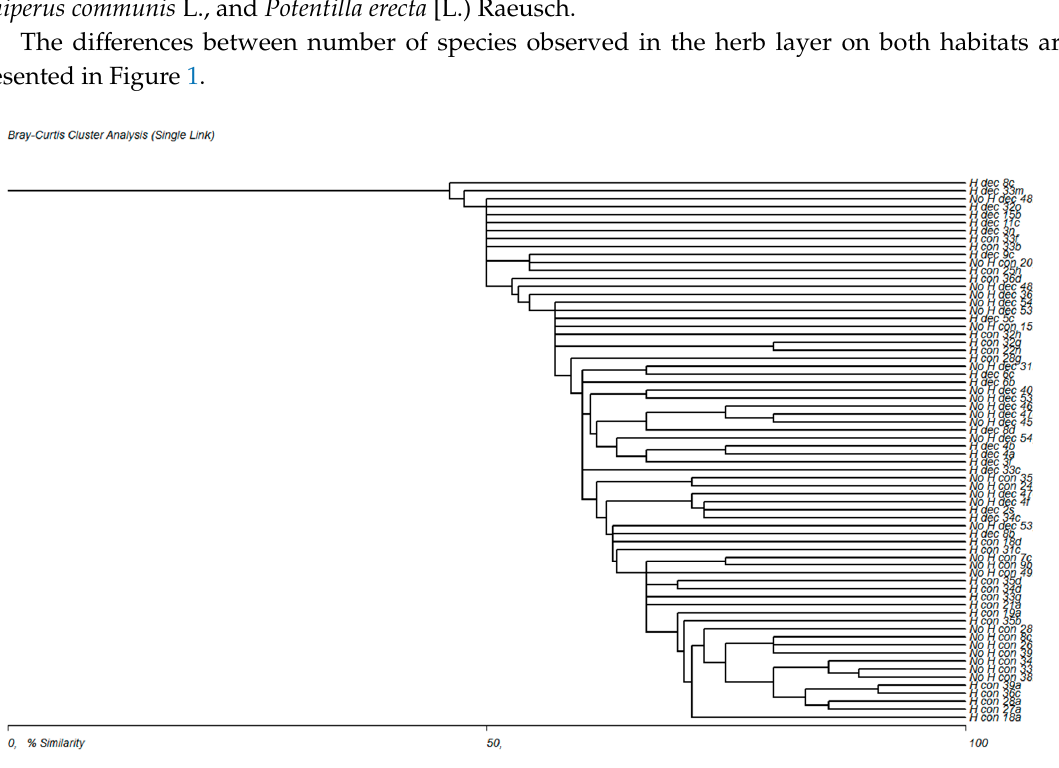
Figure 1. The similarity for clusters of species in herb layer and undergrowth lower than 0.5 m growing in all areas under examination; (H—horse present, No H—horse absent, con—coniferous forests (CF), dec—deciduous forests (DF); 7c, 54g—codes of the forest